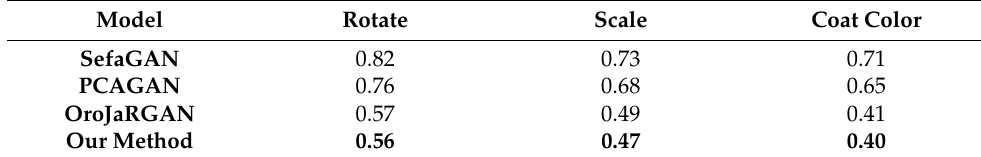
Table 3. PPL scores of LSUNCat dataset semantic attribute directions ( ↓ ).